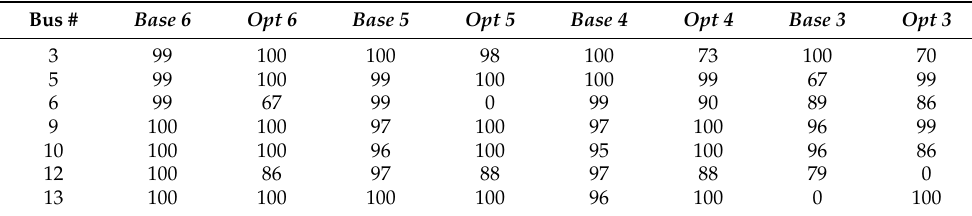
Table 5. Harmonic source locators F 1 -score for harmonic metering scenarios of Table